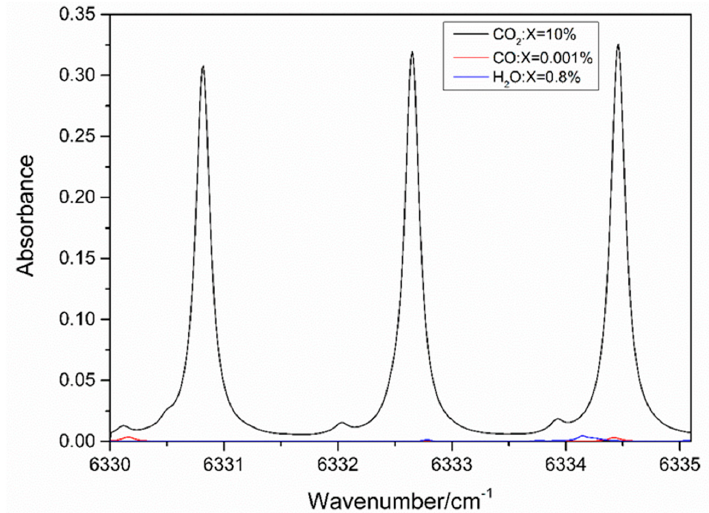
Figure 1. Simulated absorbance of CO 2 (10%), CO (0.001%), and H 2 O (0.8%) from 6330–6335.5 cm − 1 based on the HITRAN ( High Resolution Transmission) database (298 K, 1 atm).